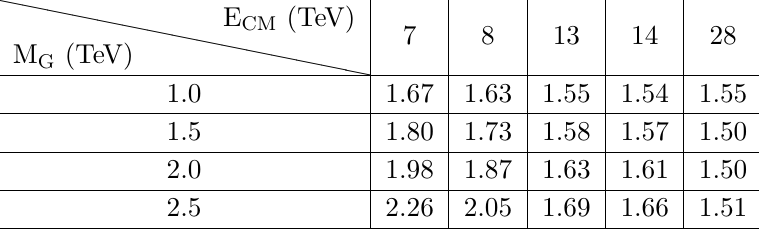
Table 3 . K-factor ( R 20 ) for different collider energies at select resonance masses for ( k q , k g ) = (0 . 1 , 1 . 0)